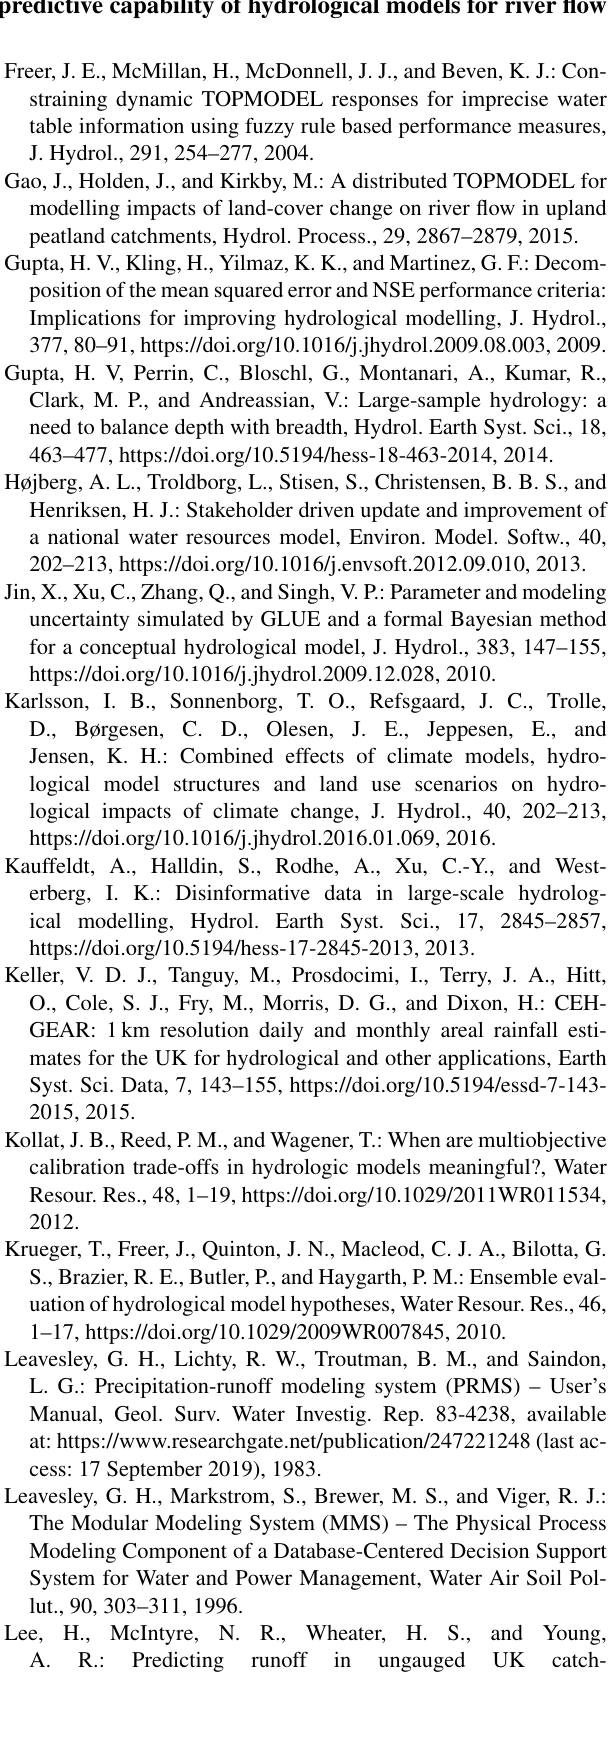
table information using fuzzy rule based performance